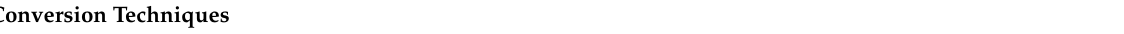
Table 5. Rain rate conversion